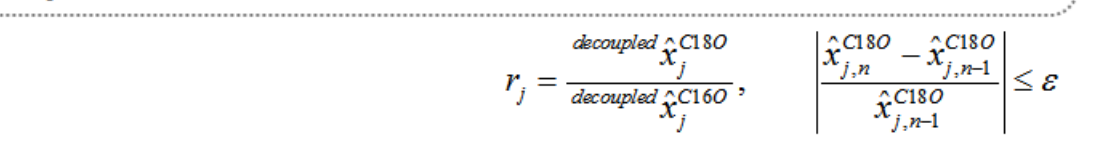
Figure 7. Schematic diagram for the two-stage Bayesian synthesis isotope inversion for atmospheric carbon